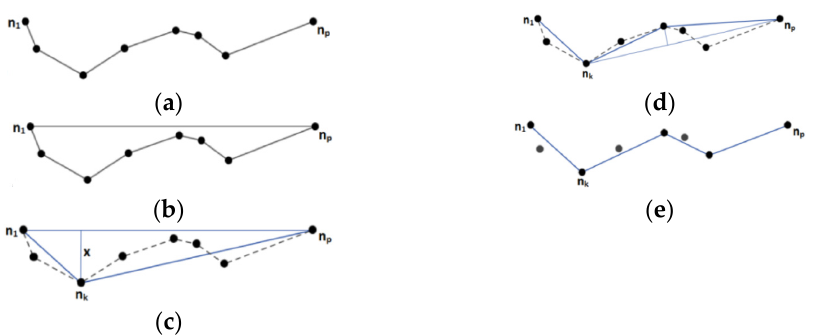
Figure 6. Trajectory thinning using the RDP algorithm. ( a ) Initial trajectory; ( b ) Point-to-edge distance; ( c ) Separation trajectory into segments; ( d ) Selection points for keeping; ( e ) Final trajectory.